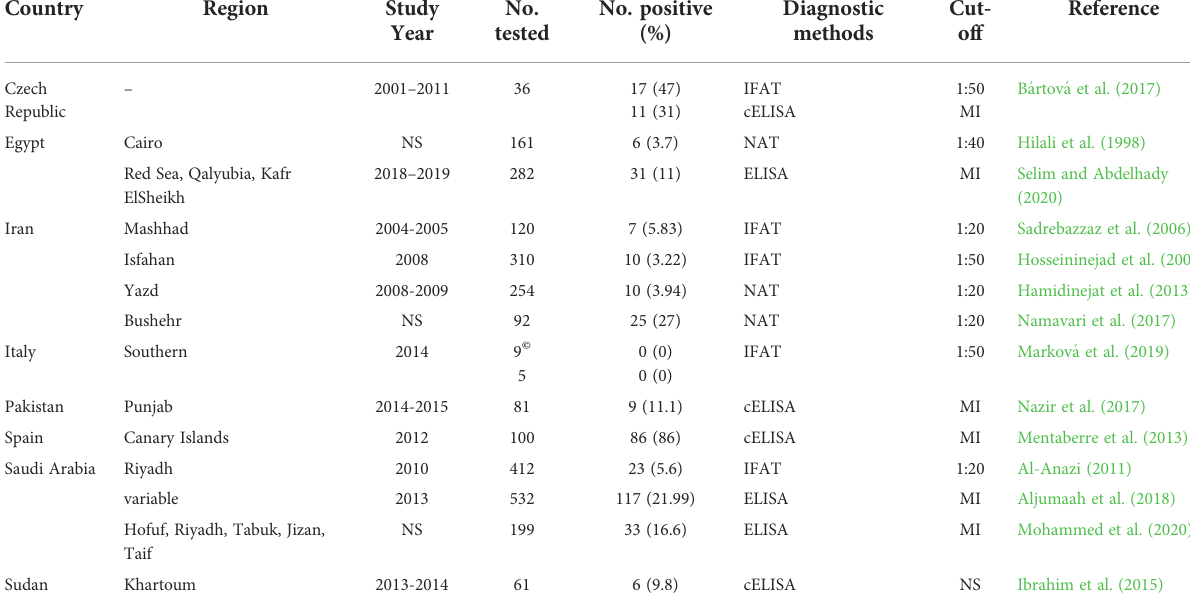
TABLE 5 Seroprevalence of anti- Neospora caninum antibodies in camels ( Camelus dromedarius and Camelus bactrianus ) worldwide. Country